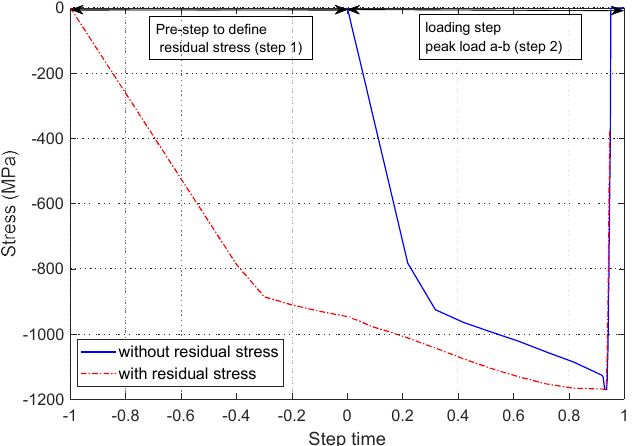
Figure 12. Stress values versus time step for the first element precisely below the critical notch without and with residual stress of −320 MPa.